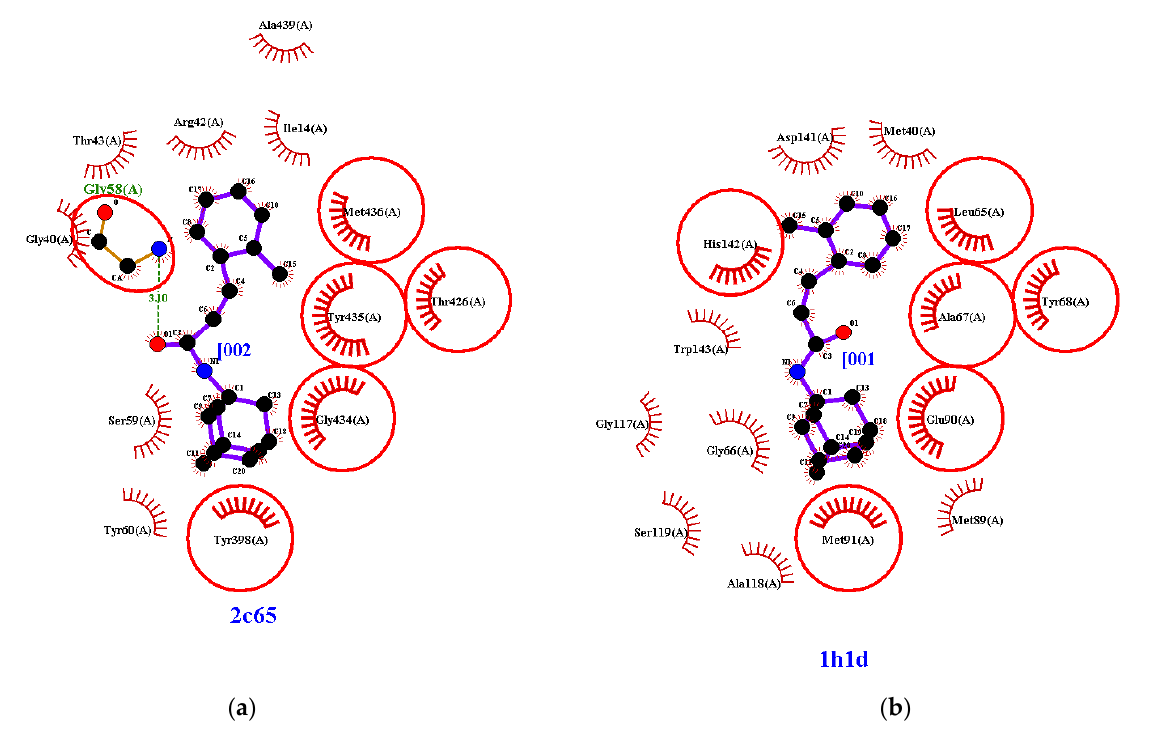
Figure 7. Observed interactions after docking of ( E )– N -(2-methylcinnamoyl)-amantadine into the active site of two putative PD targets ( a ) MAO-B (2C65) and ( b ) COMT (1H1D). The hydrogen bonding interactions are shown in green; the hydrophobic contacts are shown as for enzymes and with for ligands; the similar residues for both enzymes are shown as .